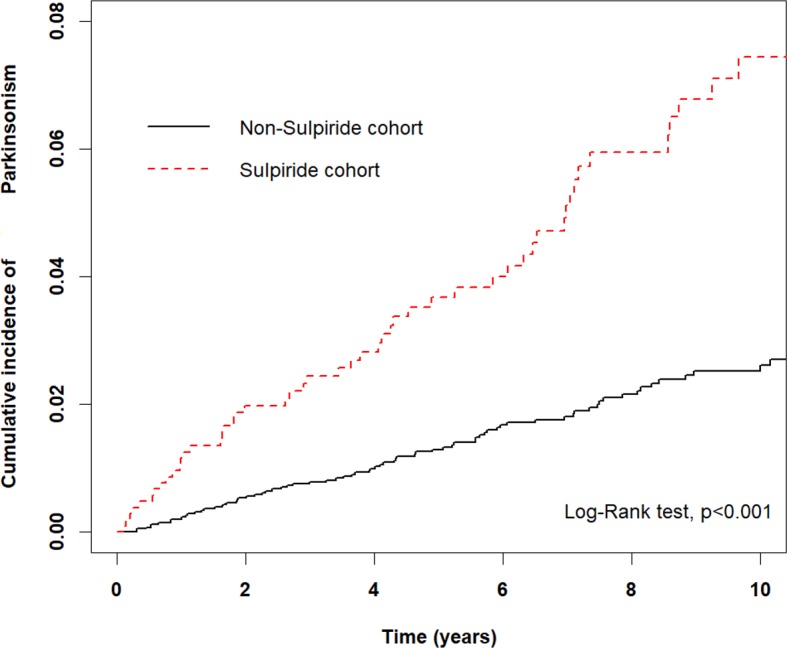
Kaplan-Meir method to determine the cumulative incidence of parkinsonism compared between the sulpiride and non-sulpiride cohort.